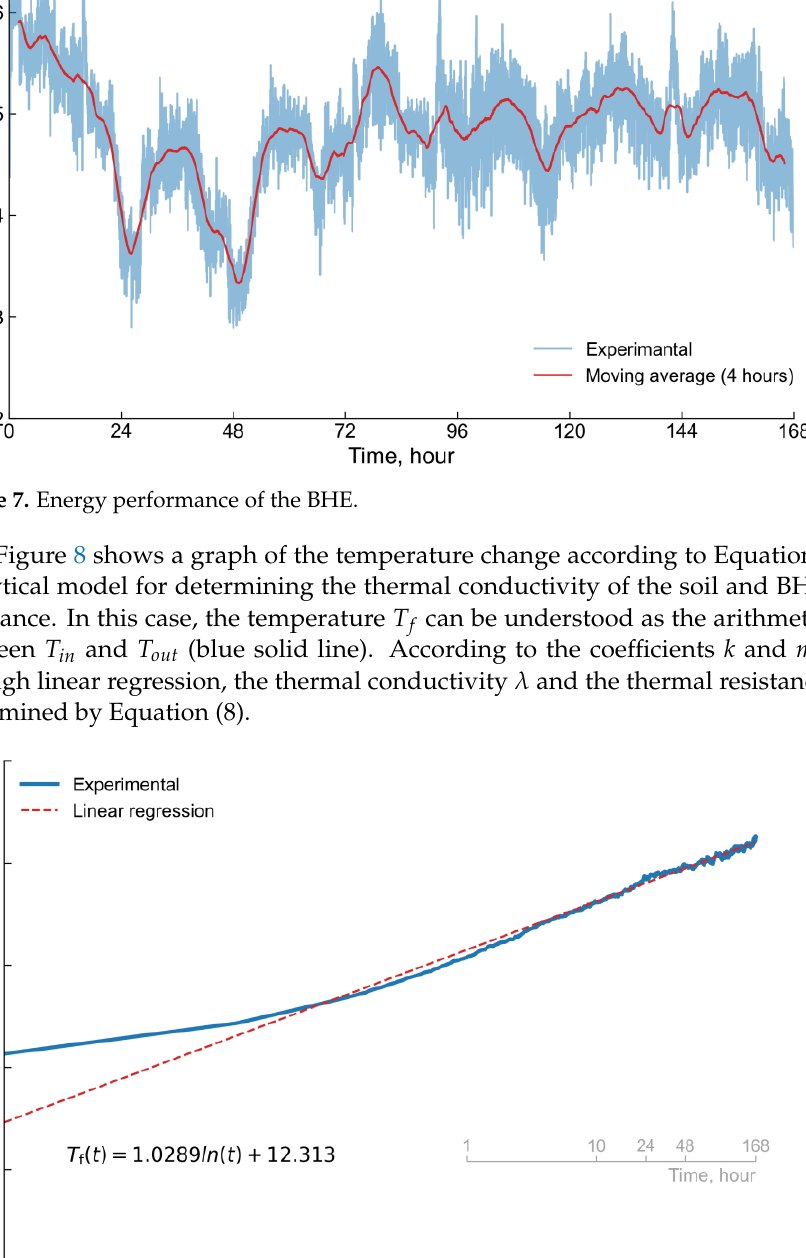
Figure 9. Regression line with different time intervals, excluding the first 10 h, 24 h, and 48 h. Table 3. Results of the analytical model. Time